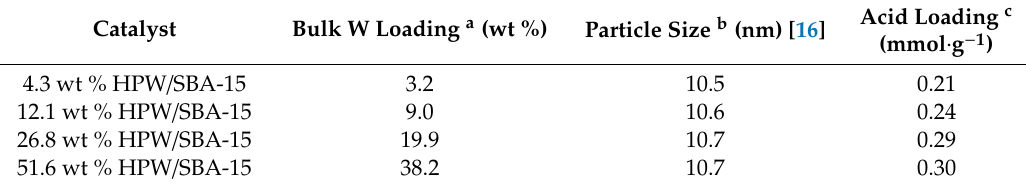
Table 1. H 3 PW 12 O 40 (HPW) content and crystallite size of HPW / SBA-15.